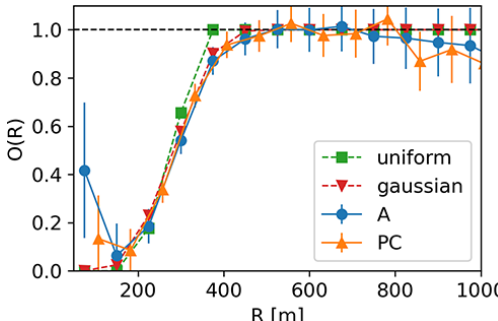
Figure 18. Estimated overlap function using analogue ( A ) and photon-counting (PC) data compared to the overlap function cal- culated from models with the assumption of a uniform/Gaussian beam, diaphragm in the focal plane, and tilted beam